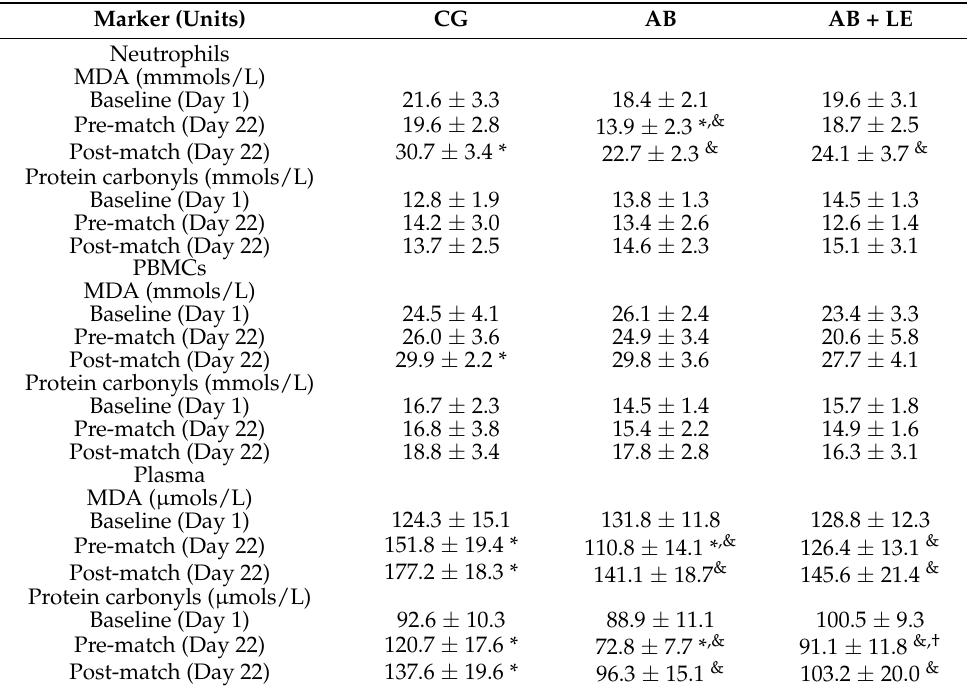
Table 3. Presence of oxidative markers in neutrophils, PBMCs and plasma determined under baseline conditions, pre-match and immediately post-match in the control (CG), almond beverage (AB) and almond beverage + Lippia extract (AB + LE)